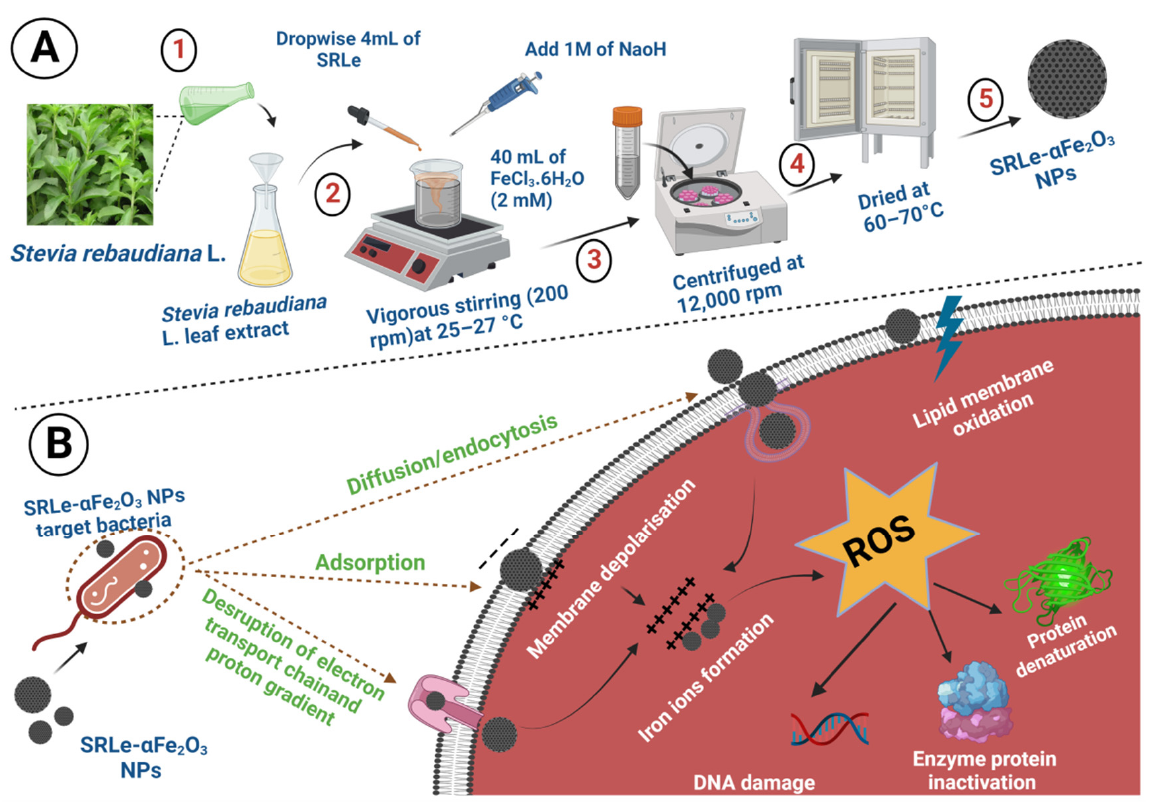
Figure 2. ( A ) Synthesis route of SRLe- α -Fe 2 O 3 NPs; ( B ) SRLe- α -Fe 2 O 3 targeting and killing of bacteria via different mechanisms.